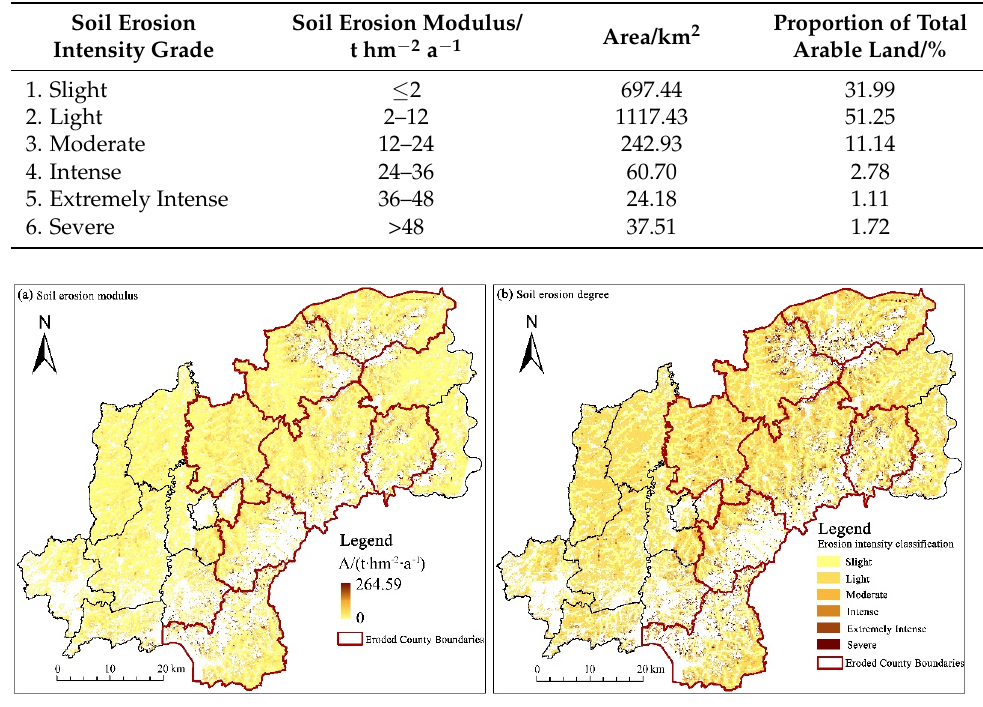
Figure 5. Spatial distribution of soil erosion modulus ( a ) and intensity grade ( b ) in the study